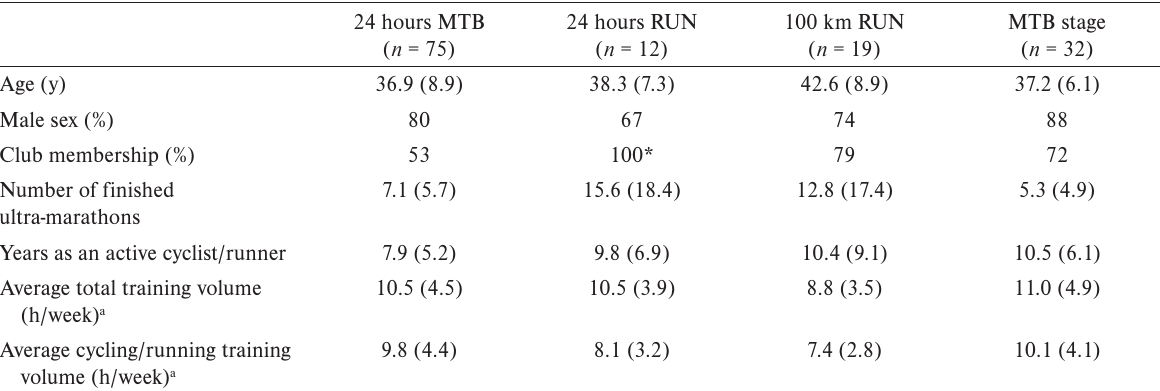
Demographic, pre-training and experience-related characteristics of all finishers (N = 138) in each type of race. Data are reported as mean (SD) except where indicated to be a